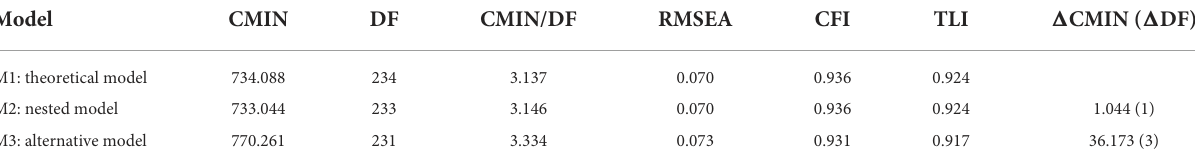
TABLE 4 Model fit of the theoretical model, nested model and alternative model.